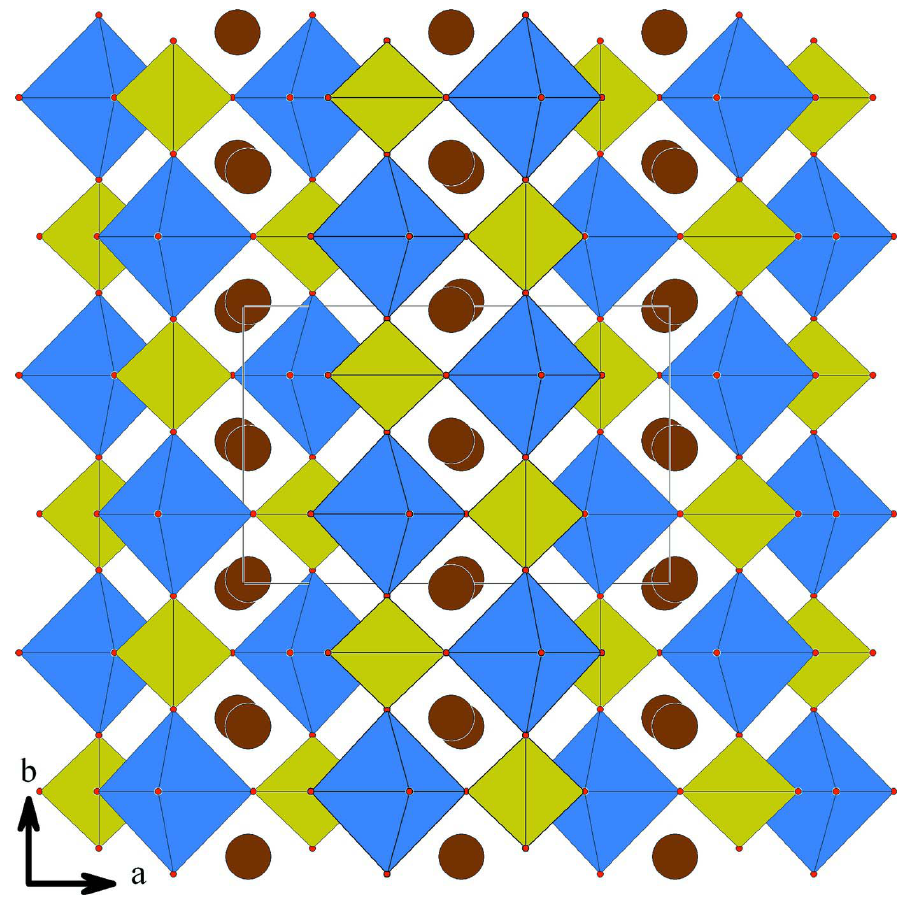
Figure 2 Projection de la structure de la variété β -NaMoO